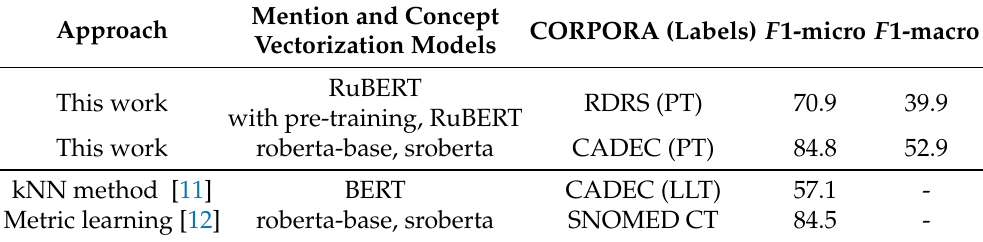
Table 5. Accuracy of normalization of ADR mentions for CADEC and RDRS (ADR subpart) corpora.